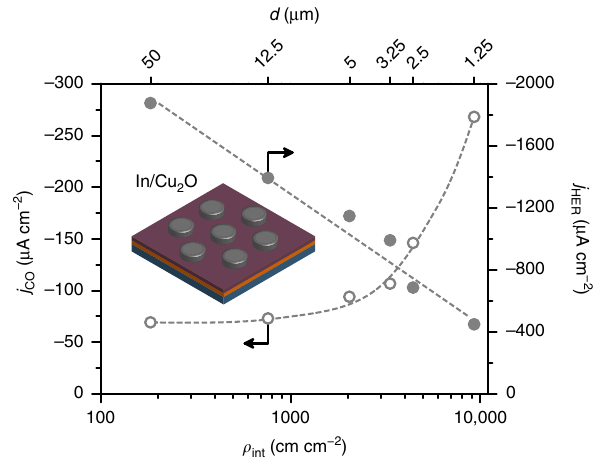
Fig. 3 Catalytic activity for CO and H 2 evolution over structured In/Cu 2 O electrodes. The partial current density for CO ( j CO ) and for H 2 ( j HER ) over In/Cu 2 O electrodes follow a similar trend with the interfacial density ( ρ int ) as over In 2 O 3 /Cu 2 O electrodes, indicating that In and In 2 O 3 act as equivalent sources of indium for the formation of the active phase on Cu 2 O substrates upon exposure to reaction